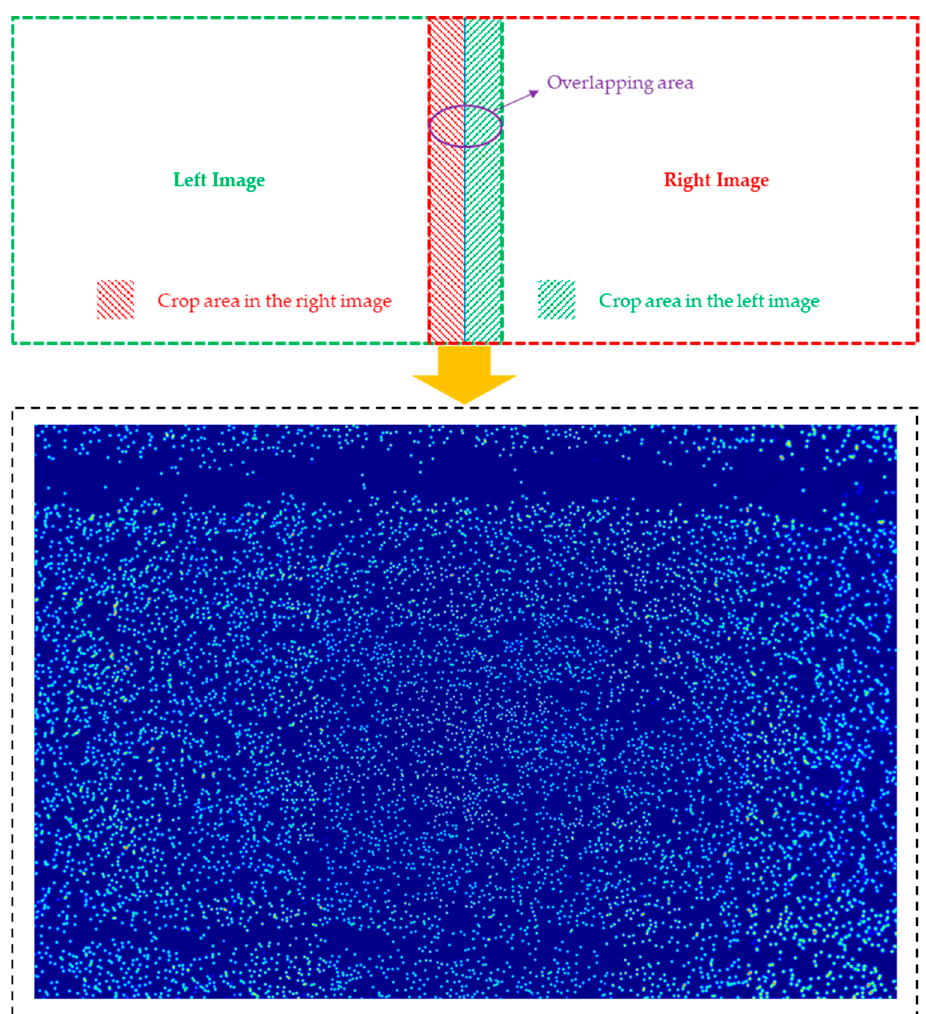
Figure 9. The result of the estimated density map of one sample. Since the ground truth of the test data were not obtained, we integrated the density map estimation results of the training and validation samples (Figure 10a). The R 2 between the estimated value and the ground truth was 0.9919, which was a highly significant correlation. It showed that the method of DM-Net construction and density map splicing was effective. All test data were estimated and converted into standard units by sampling area, which was compared with the value of the manual survey (Figure 10b). The